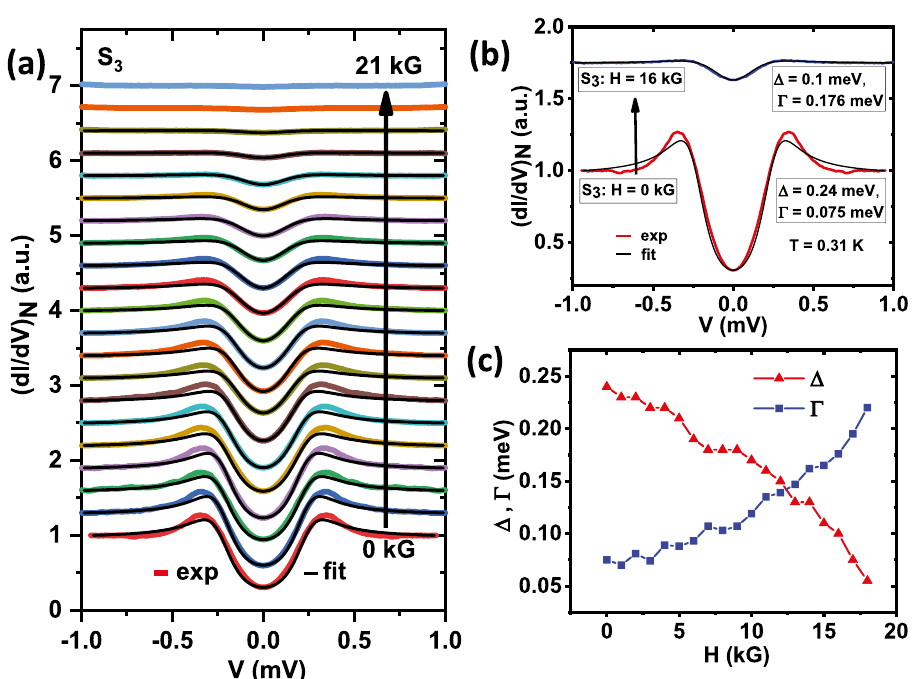
Figure 3. ( a ) Magnetic field ( H ) dependence of tunneling conductance spectra S 3 (color lines) with theoretical fits (black lines) all measured at T 310 mK. ( b ) Spectra S 3 in the environment of H = 0 and H = 16 kG field, ∼ c -axis of the crystal and a better fit at higher field is visible. ( c ) along with corresponding fitting parameters. H (cid:31) Evolution of (cid:31) and Ŵ with the magnetic field, extracted from plot ( a